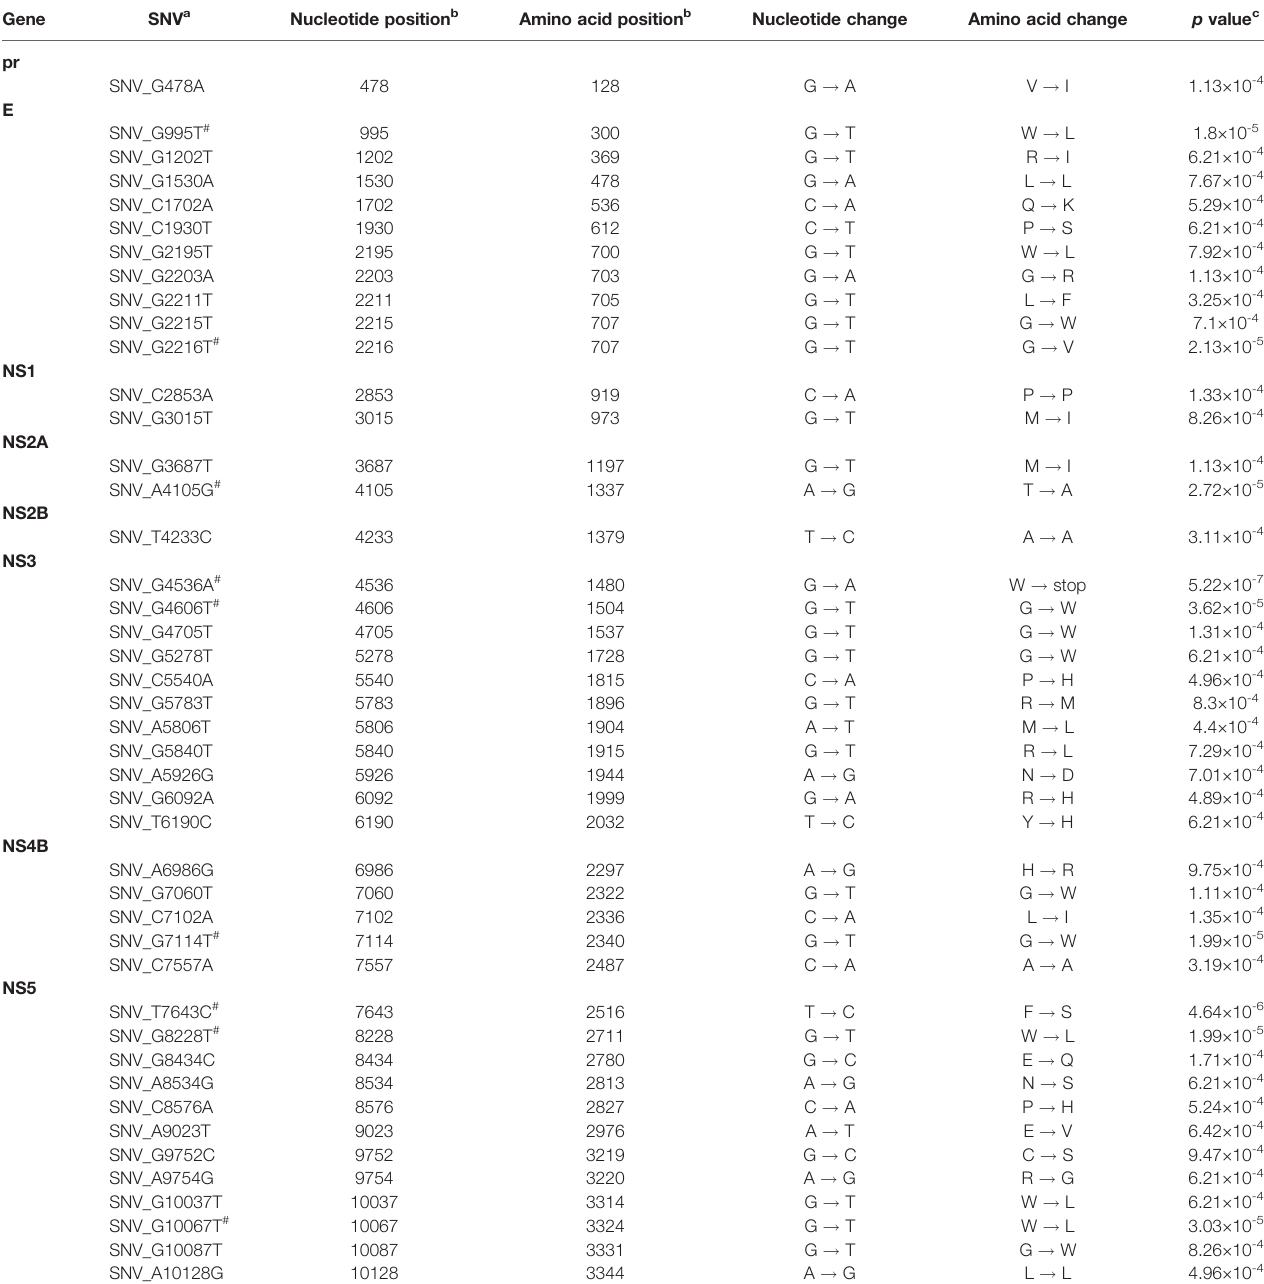
TABLE 1 | SNVs associated with disease severity in patients with DENV-2 infection.